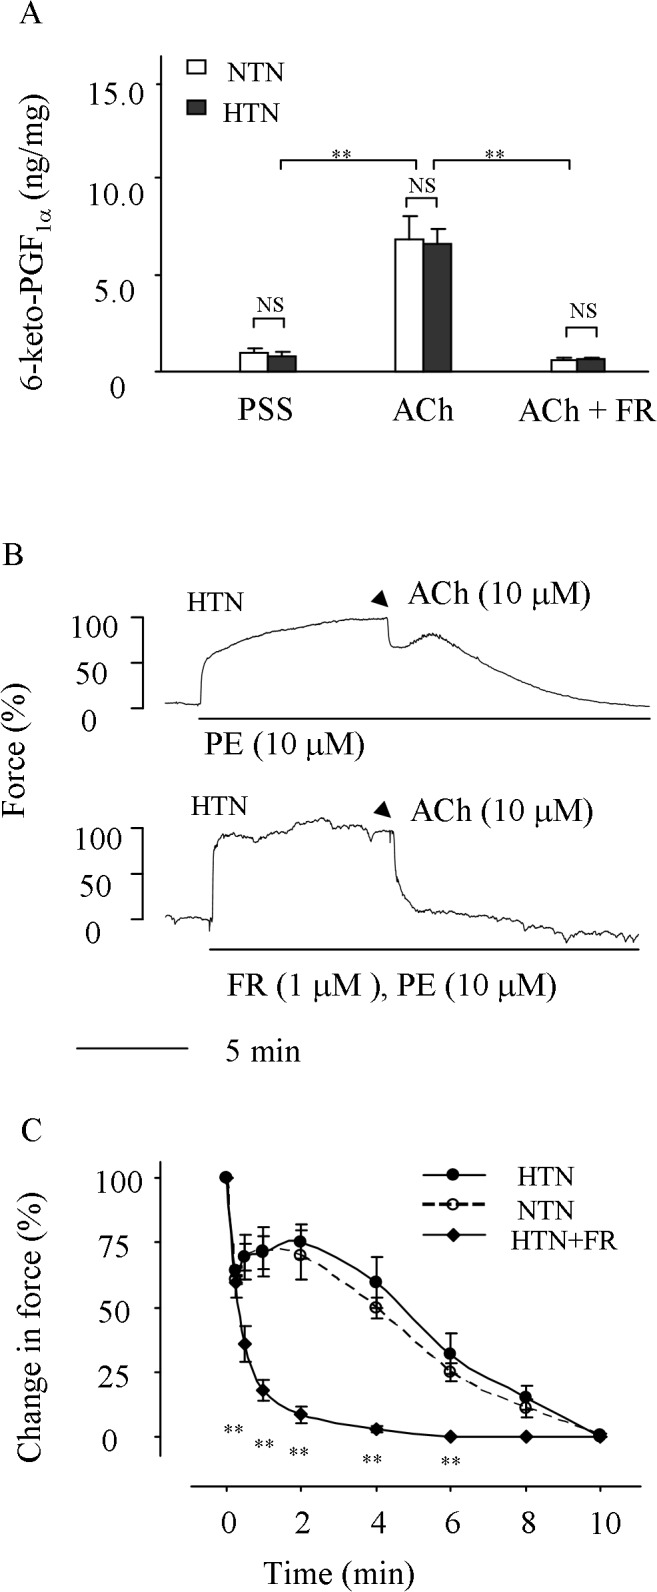
PGI2 synthesis and response evoked by ACh in 2K1C hypertensive carotid arteries.
A: detection of the PGI2 metabolite 6-keto-PGF1α evoked by ACh with EIA in 2K1C hypertensive (HTN) and control normotensive (NTN) arteries with/out the presence of 1 μM COX-1 inhibitor FR122047 (FR). Values were expressed as mean ± SEM (n = 6 for each). ** P<0.01; NS, not significant. B: represent traces showing time-courses of the relaxation evoked by ACh (10 μM) in HTN pre-contracted with PE (10 μM) and that obtained in the presence of FR (HTN+FR). C: summary of the time-course of the relaxation evoked by ACh in HTN as compared to that of NTN or HTN+FR. Values were expressed as mean ± SEM (n = 5 for each); **P<0.01 vs. the value of HTN.